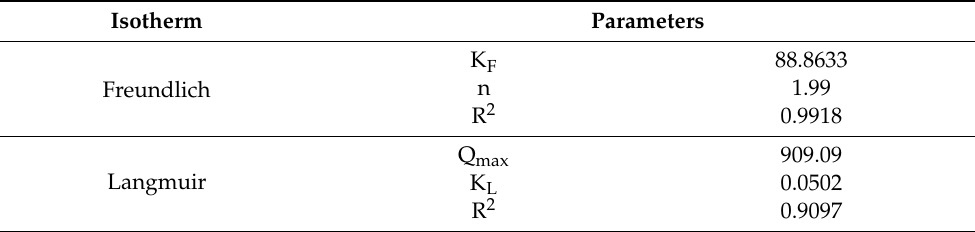
Table 2. Isotherm parameters, for amoxicillin adsorption onto the CMT-g-PANI@Fe 2 O 3 bioadsorbent.